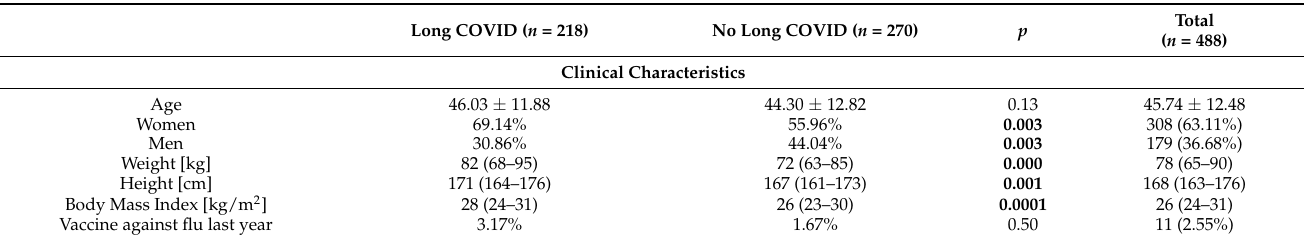
Table 1. The clinical characteristics—differences between groups with and without LC.